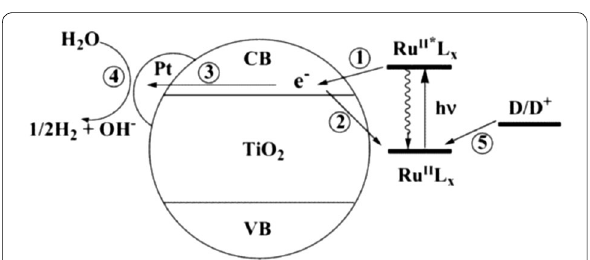
200 nm. Copyright permission from ACS [95] =